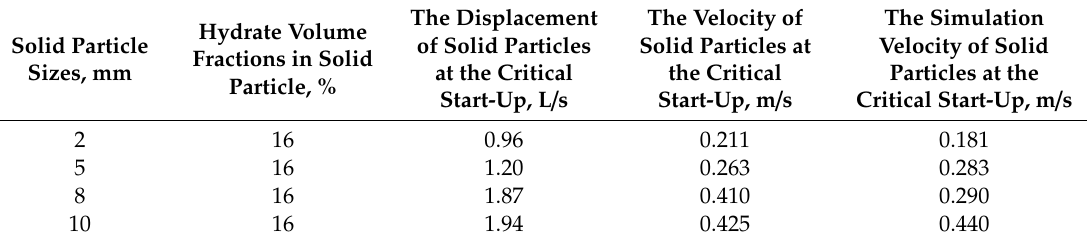
Table 3. The experimental data under di ff erent solid particle sizes.